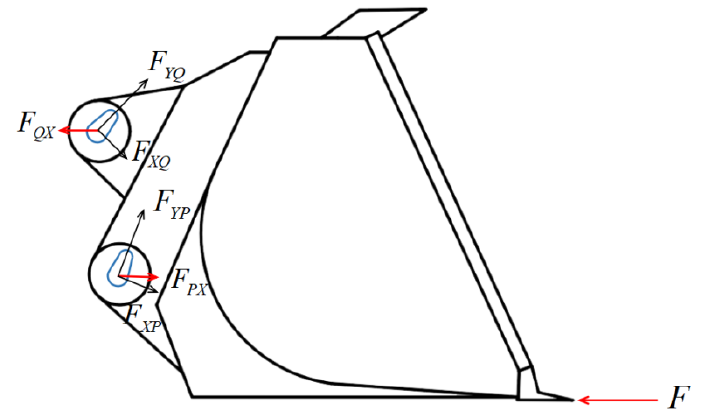
Figure 7. Bucket force diagram.